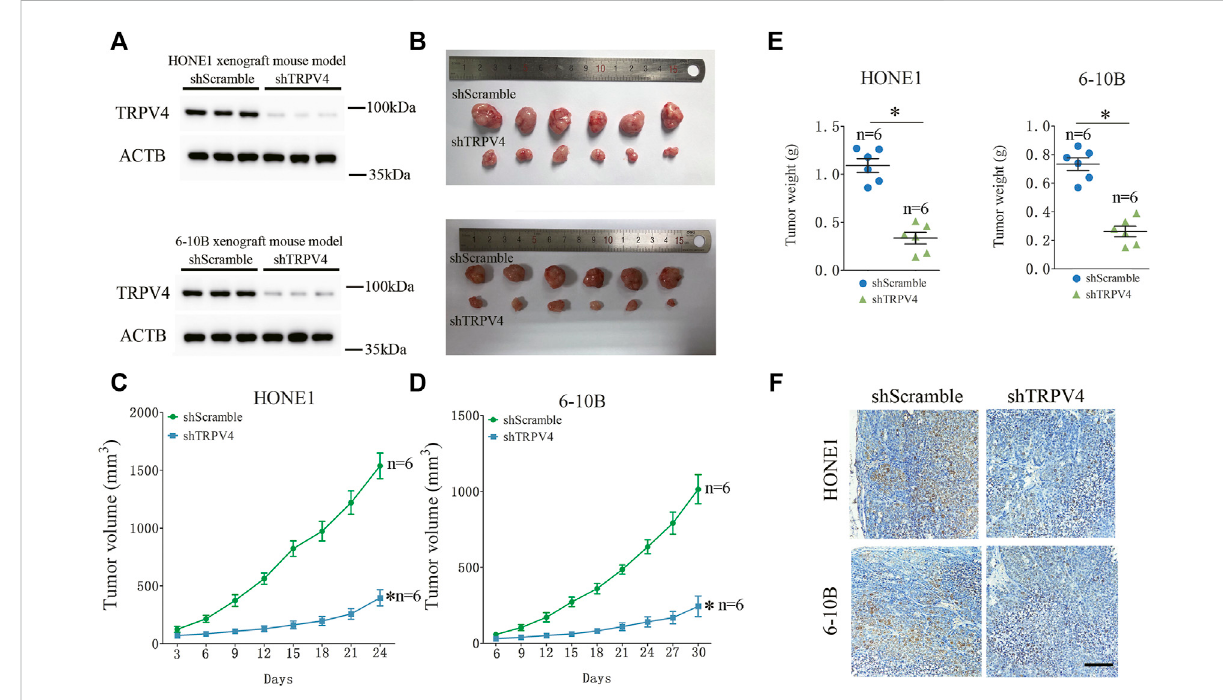
FIGURE 4 TRPV4 regulates NPC cells growth in vivo (A) Immunoblot showing TRPV4 expression in the xenografts of NPC cells transfected with shScramble or shTRPV4 (n = 3). (B – D) Representative images of tumors from the indicated groups (n = 6). (E) The tumor weight in the indicated groups (n = 6). (F) Representative images of immunohistochemical staining of Ki-67 in HONE1 (upper) or 6 – 10B (down) xenograft tumor tissues transfected with shScramble or shTRPV4 (n = 6). Scare bar = 100 μ m. The data represent the mean ± SEM. * p < 0.05, versus